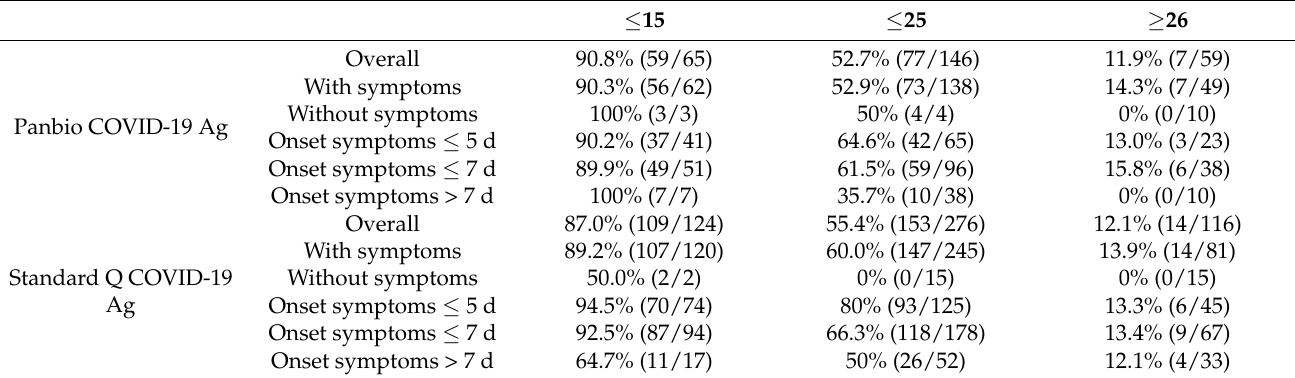
Table 3. Agreement between RT-PCR positives and Ag-RDT regarding to CT